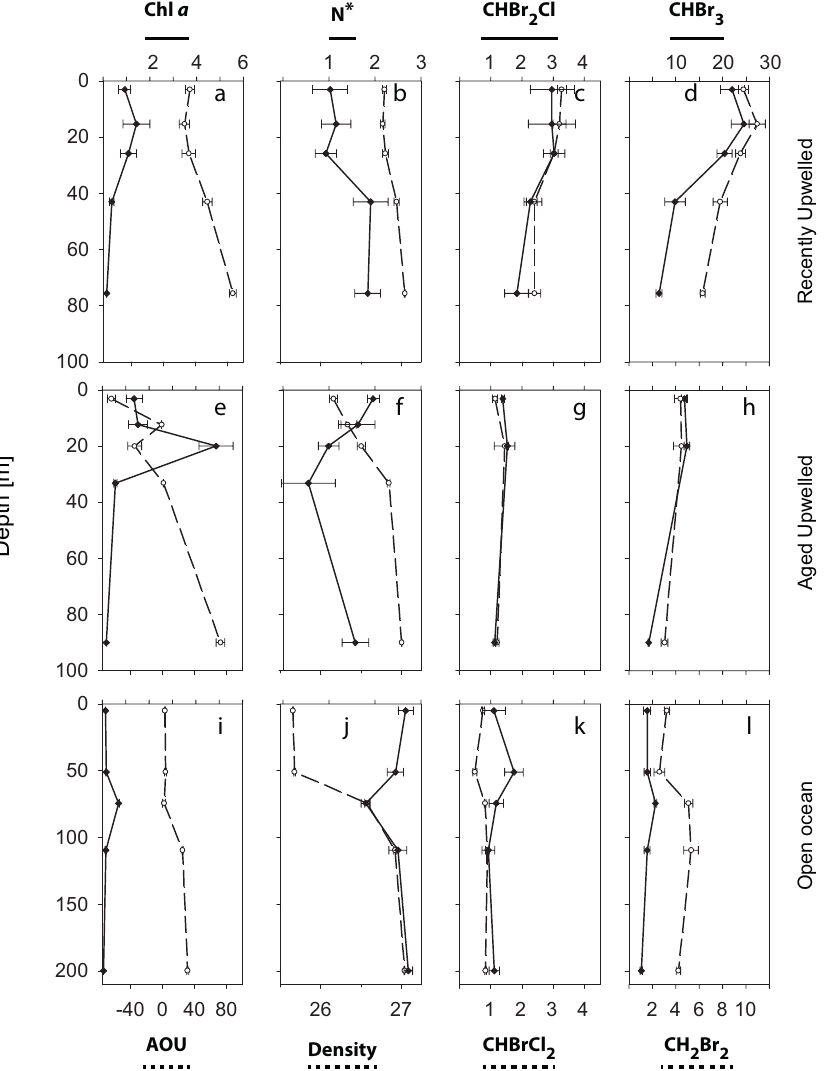
Fig. 5. Depth profiles of chlorophyll a [mgm − 3 ], AOU [µmolL − 1 ], N* [µmoll − 1 ], density [ σ ] and brominated halocarbons [pmoll − 1 ] at three fixed stations. Variables are expressed as means of all samples during a daily cycle at the different depths (surface, upper thermocline, chlorophyll maximum, lower thermocline and bottom) and water mass: (a) – (d) Recently upwelled waters. (e) – (h) Aged upwelled waters. (i) – (l) Open ocean waters. Full lines use upper x-axis. Dashed lines refer to lower x-axis. Error bars show